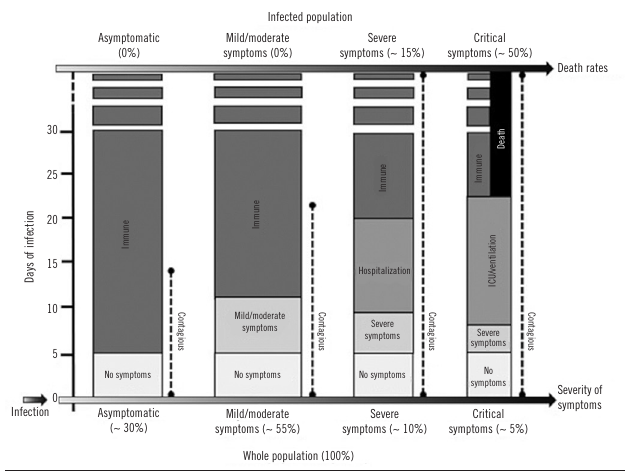
FIGURE 1 – Symptoms and evolution of COVID-19 Source: based in Guan WJ, et al ., 2020 (41) ; adapted from DASA, 2020 (42) . ICU: intensive care